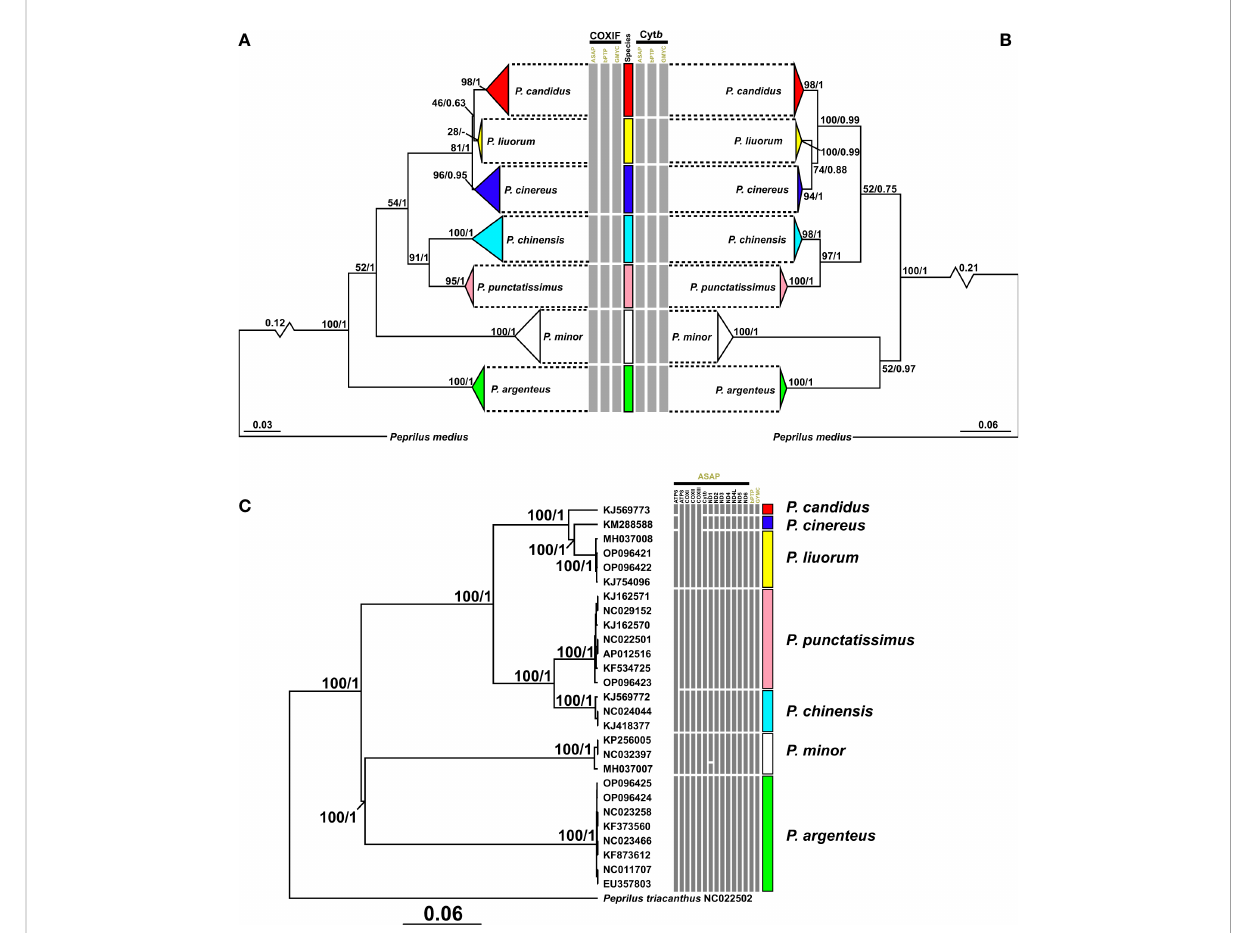
FIGURE 4 ML trees of the COXIF (A) , Cytb (B) , and MG (C) datasets. Bootstrap values and posterior probabilities obtained in ML and BI analyses are shown on each node. The broken lines indicate that these branches are condensed, and the original branch lengths are shown on these branches. ML, maximum likelihood; BI, Bayesian